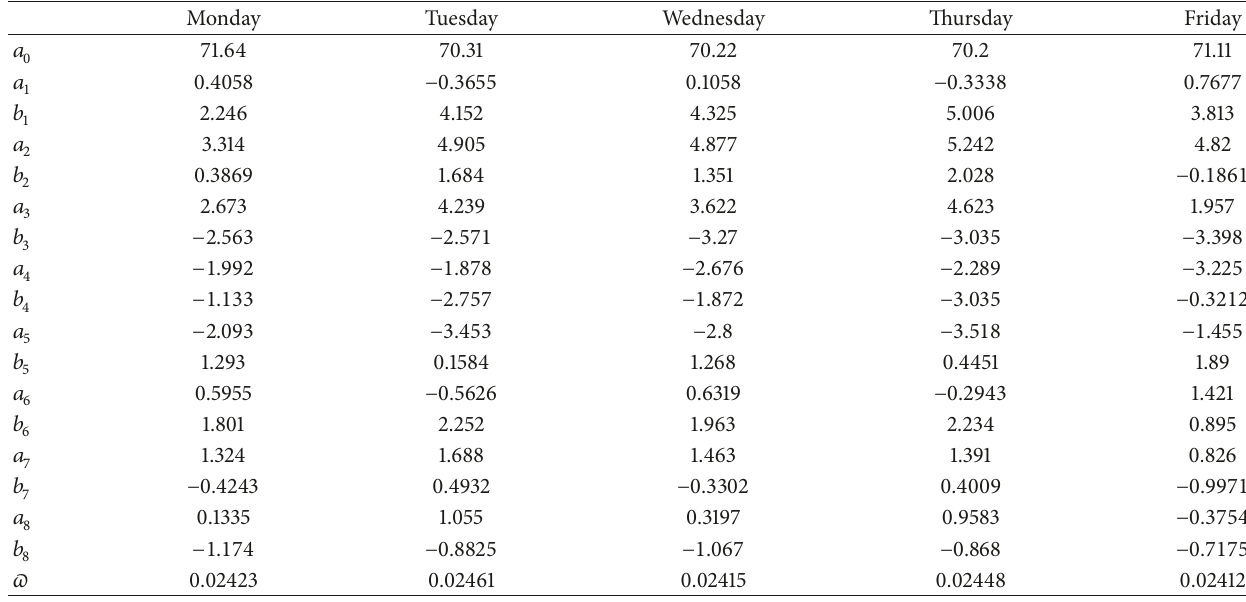
Table 1: Coefficient of Fourier series.